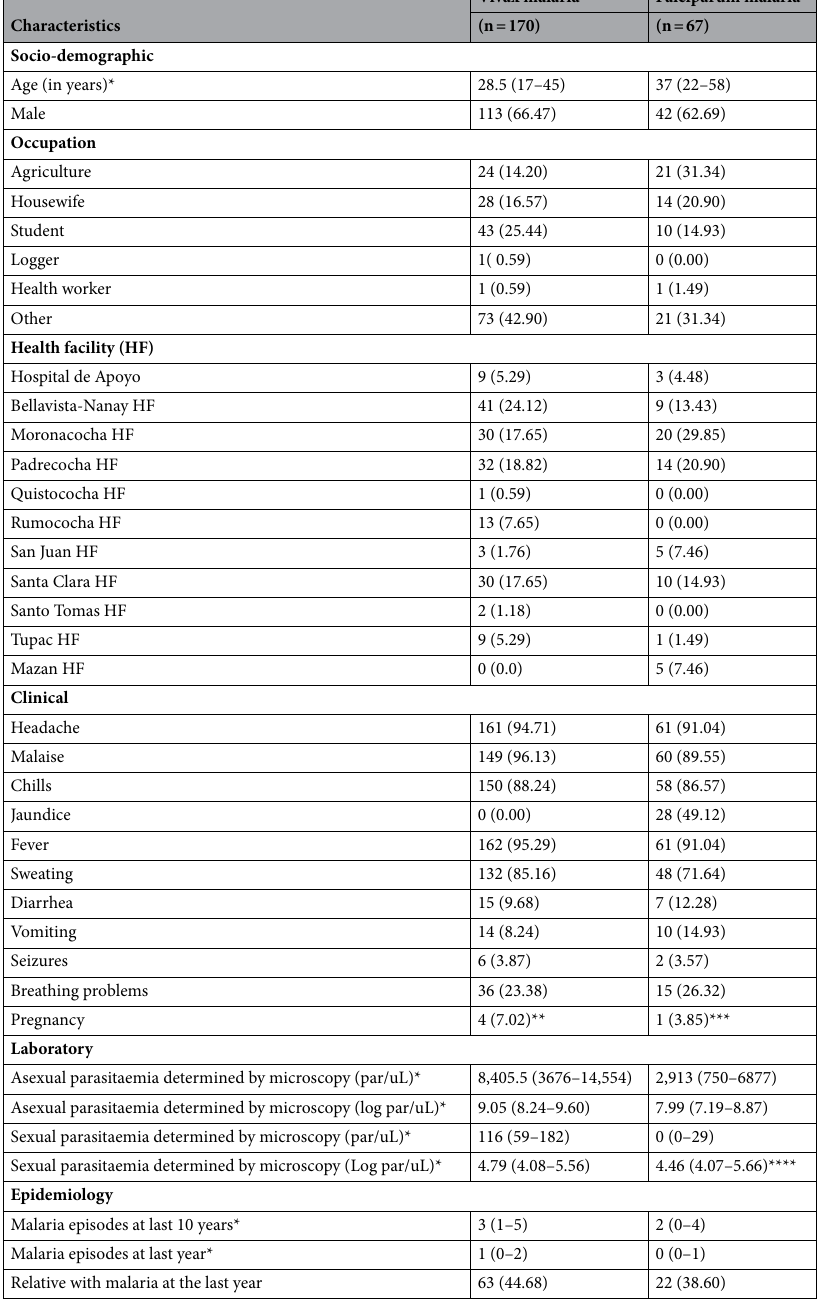
Table 1. Sociodemographic and household characteristics of enrolled participants. * Median (IQR) **(n = 57), ***(n = 26), ****(n =